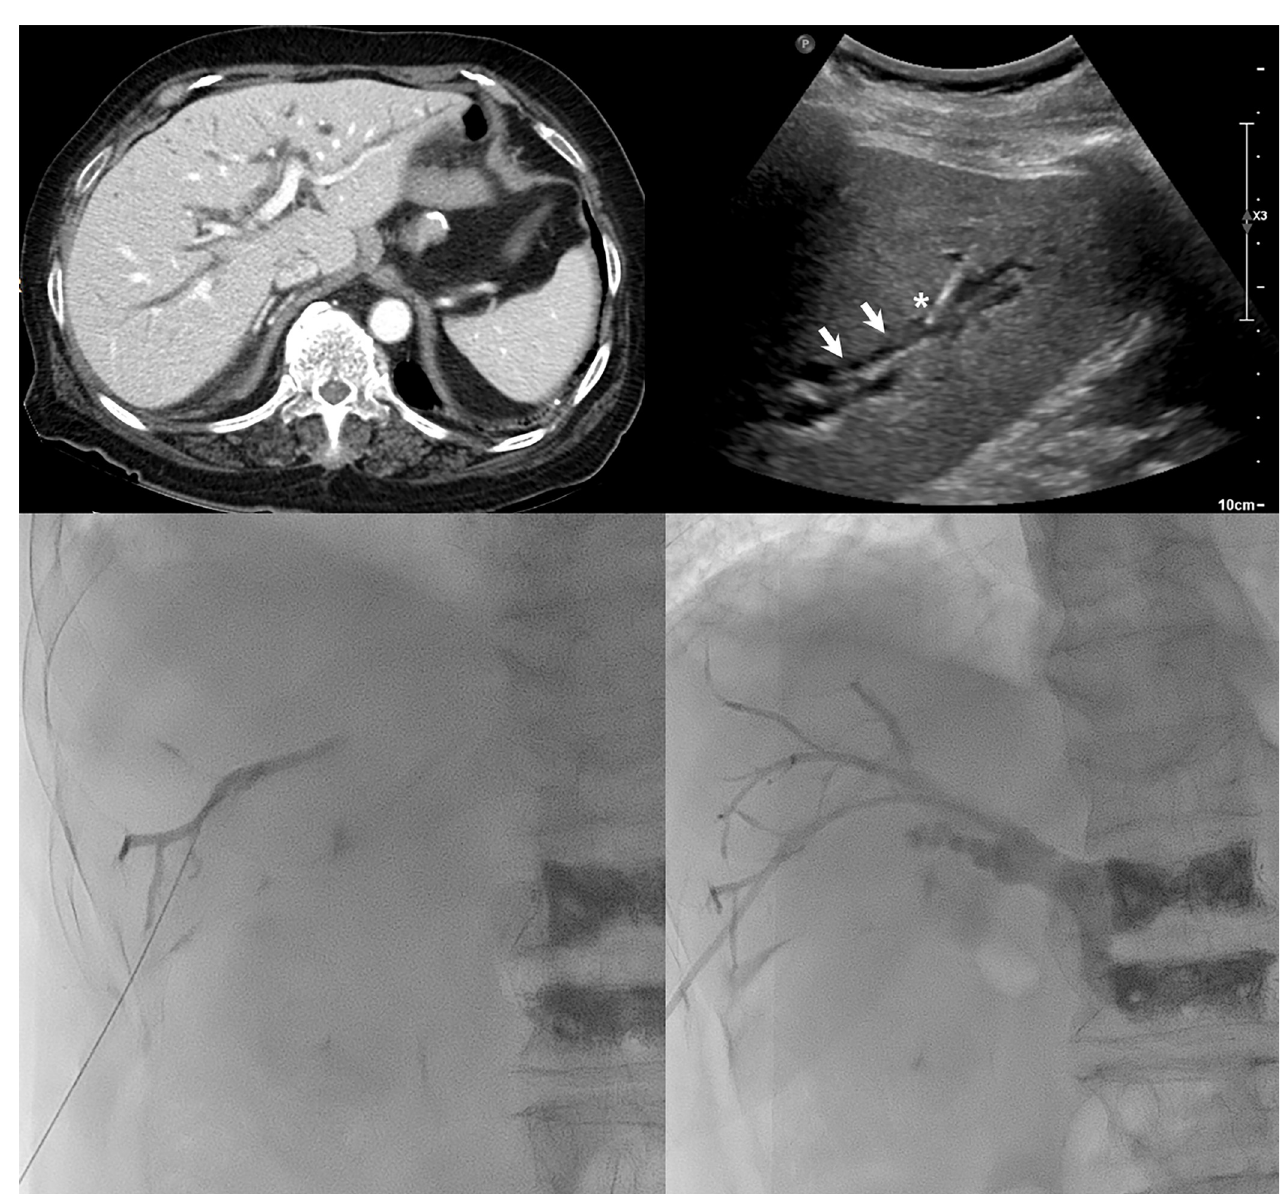
Fig 2. An 83-year-old woman with jaundice due to distal cholangiocarcinoma. A. Portal phase of contrast-enhanced computed tomography scan demonstrates diffuse dilatation of intrahepatic bile ducts. B. Intercostal right lobe ultrasonography scan shows diffuse dilatation of intrahepatic bile ducts (white arrow). Note that a 21-gauge Chiba needle was inserted into the target bile duct (white asterisk). C. Under fluoroscopy guidance, a mixture of contrast and normal saline was carefully injected and the bile duct confirmed. D. An 8.5 Fr drainage catheter was inserted at the distal common bile duct level.